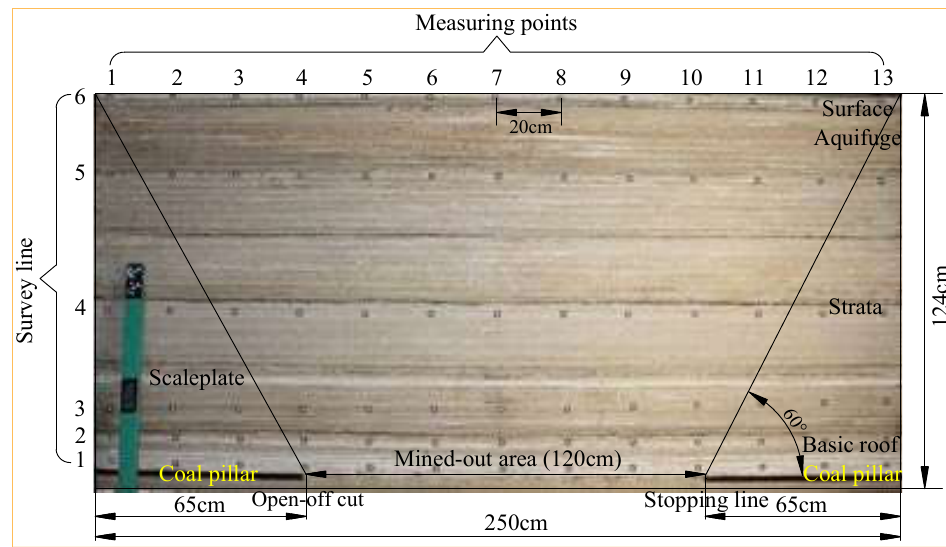
After the analogue model was laid and dried for ten days, six survey lines were set in the front of the model to measure the deformation of the overlying layers and especially the aquifuge. Each survey line consists of 13 measuring points, and the distance between each measuring point is 0.2 m. The purpose of survey Line 1 is to monitor the deformation of the main roof, while Line 2 to Line 4 aim to measure the migration of the bedrock. Line 5 and Line 6 are arranged to monitor the deformation of the aquifuge and ground surface, respectively. The analogue model after all MRs are extracted and backfilled, as well as the arrangement of the measuring points, are shown in Figure 8.